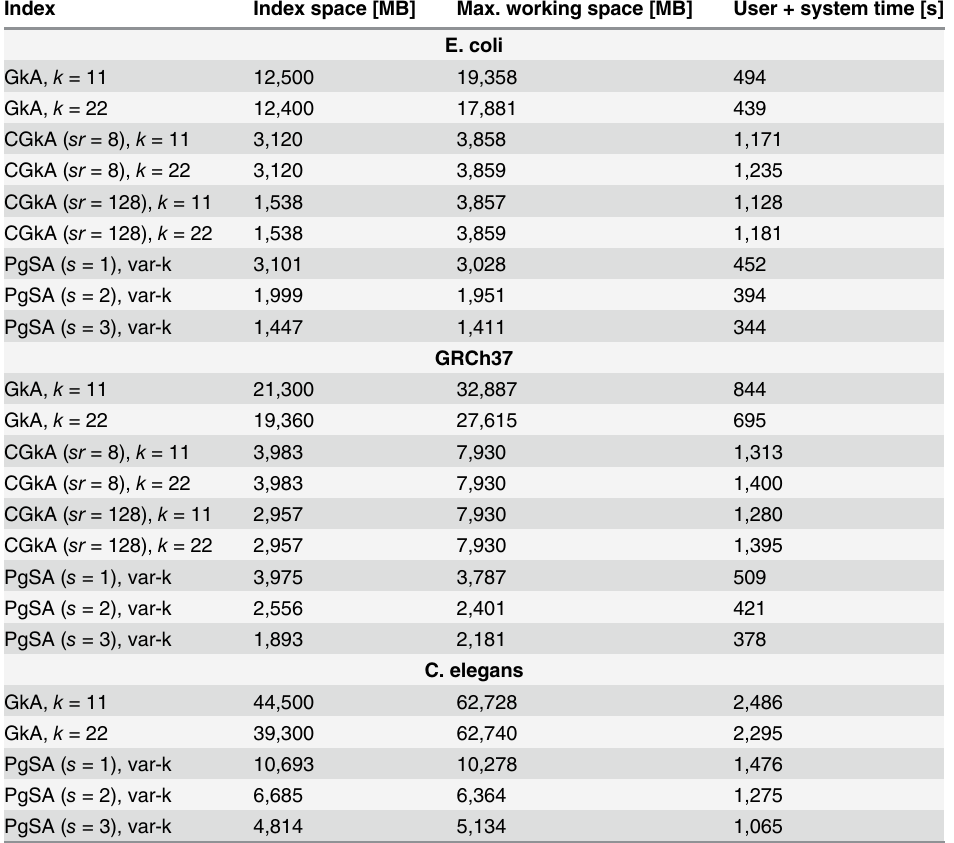
Table 6. Index construction times and memory usages for the GkArrays, CGk and PgSA algorithms. For the CGkA algorithm sr denotes the sampling rate parameter, being a space-time tradeoff. CGkA crashed on the C. elegans dataset, in all tested configurations. GkA index is not written to disk, as opposed to the other two tools.